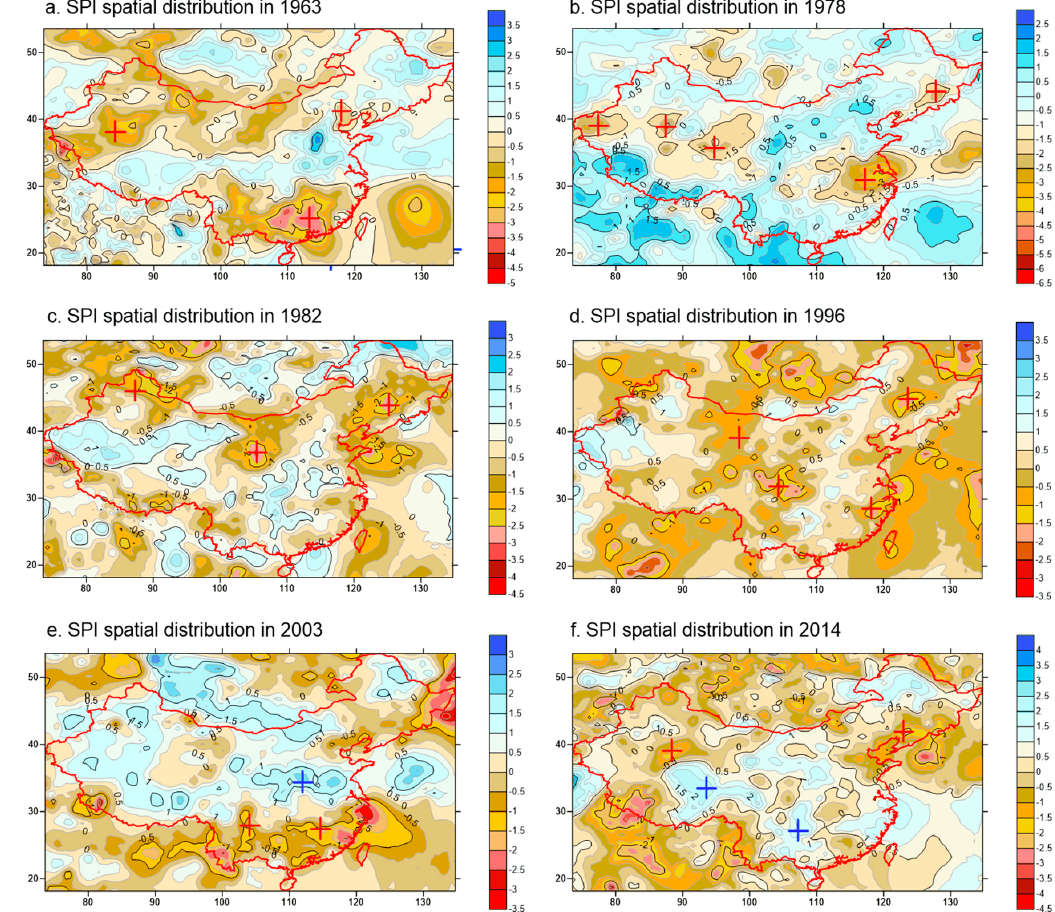
Figure 4. Spatial distribution of six-month (rainy season: April to September) SPI across China in 1963, 1978, 1982, 1996, 2003, and 2014. Red crosses indicate drought locations, while blue crosses indicate flood locations. SPI spatial distribution was interpolated using Kriging method in Surfer 10.0. ( a ) SPI spatial distribution in 1963; ( b ) SPI spatial distribution in 1978; ( c ) SPI spatial distribution in 1982; ( d ) SPI spatial distribution in 1996; ( e ) SPI spatial distribution in 2003; ( f ) SPI spatial distribution in 2014. Table 2. A synthesized summary of drought and flood disaster (and type) distribution in China in 1963, 1978, 1982, 1996, 2003, and 2014.